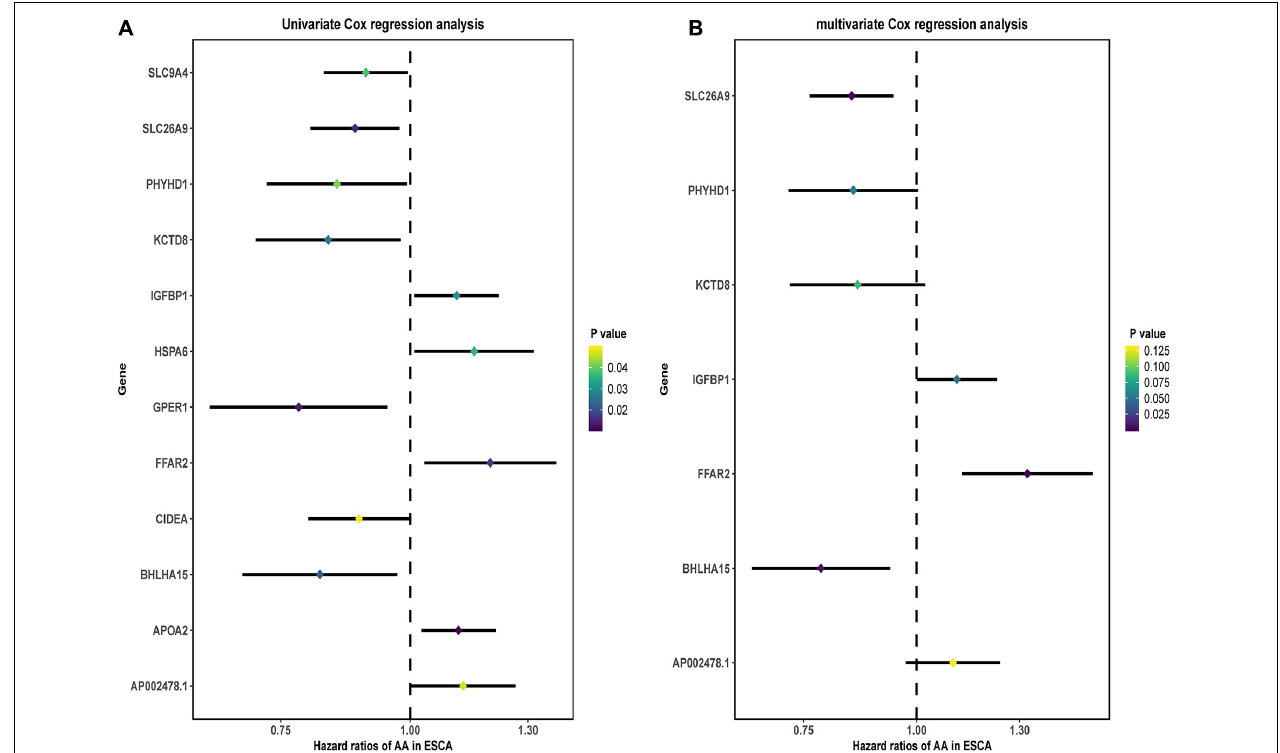
( Figure 4A ), the seven-gene prognosis prediction model ( Table 1 and Figure 4B ) was eventually filtered and was independently associated with prognosis. The risk score was calculated using a multivariate Cox proportional hazard regression model: